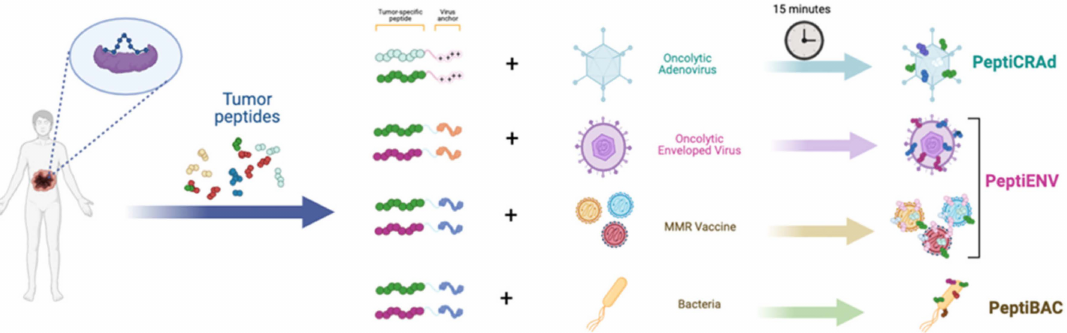
Figure 2. Schematic representing the Pepti-technology used to the rapid development of personalizing oncolytic immunotherapy platforms.